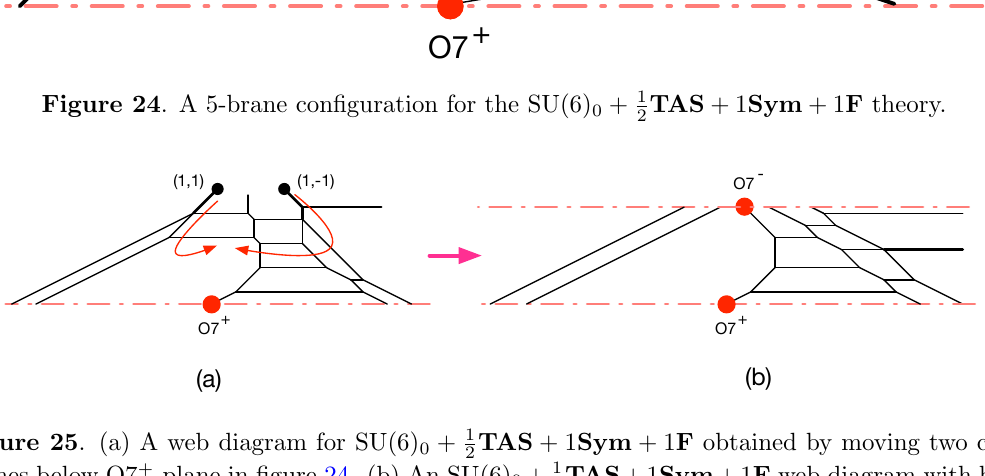
Figure 25 . (a) A web diagram for SU(6) 0 + 1 branes below O7 + -plane in (cid:12)gure 24. (b) An SU(6) 0 + 1 O7 (cid:0) - and O7 +